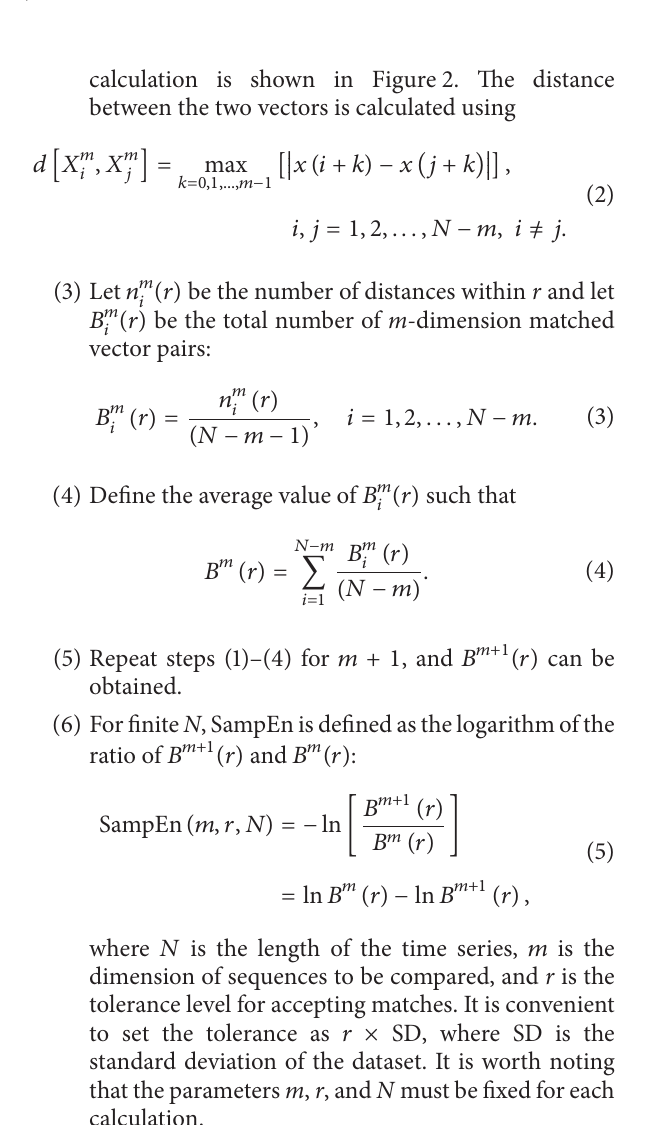
Figure 2: A schematic illustration of the distance calculation ( 𝑚 = 2